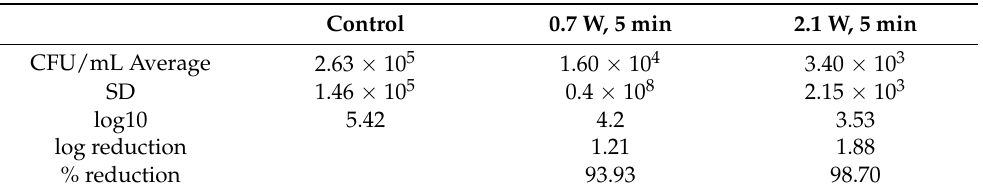
Table A3. Bactericidal effect of aPDT/PACT with IGC-Nano/c on E. faecalis biofilm in an infected root canal model. Actual values of data indicated in Figure 3 are shown. Lasers with different powers were applied for 5 min with air-cooling.